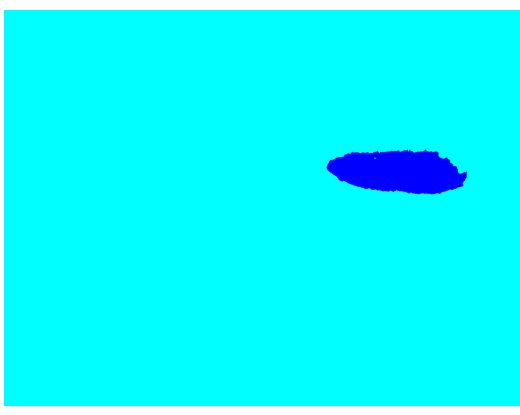
Figure 6. Segmented image with single cultivated area shown in